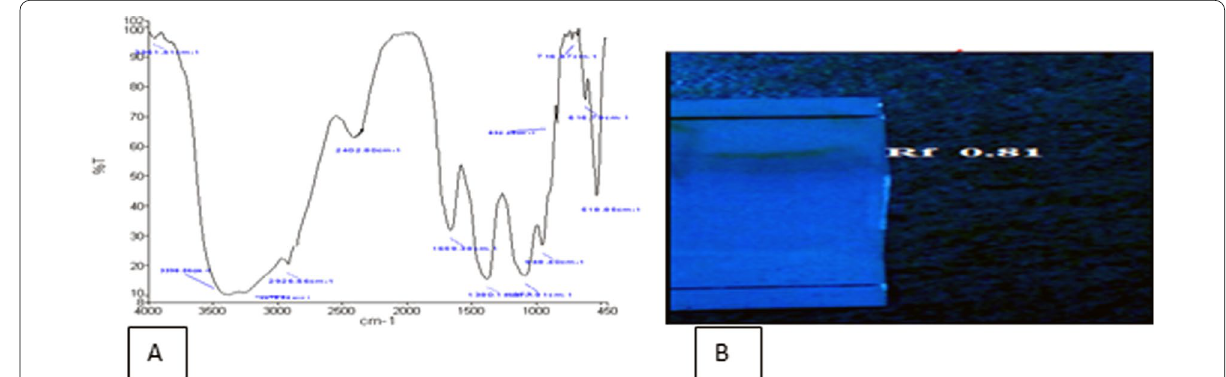
Fig. 2 A Characterization of biosurfactan using FTIR analysis from Kocuria rosea ABR6. B Chromatogram biosurfactant produced by Kocuria rosea